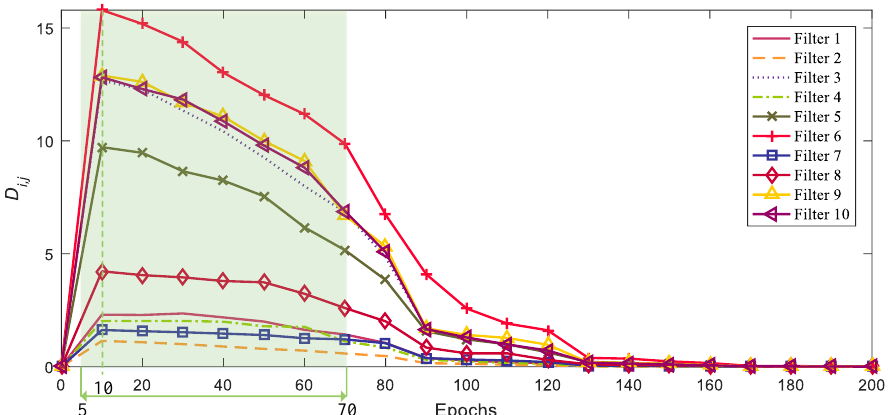
Figure 2. The change curves of filter parameters during network training. The fluctuation of the curves reflects the difficulty of learning different filter